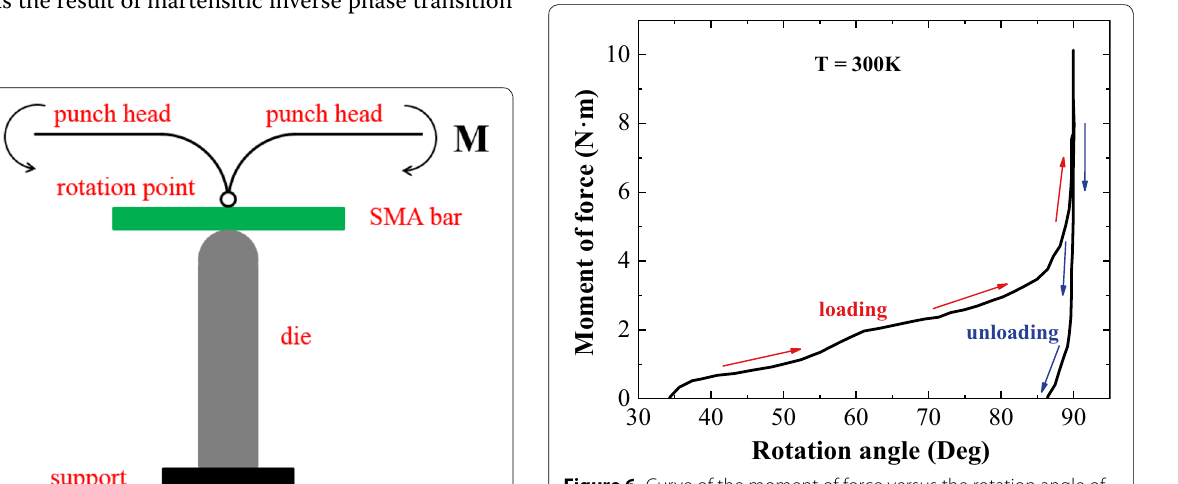
Figure 6 Curve of the moment of force versus the rotation angle of punch head at 300